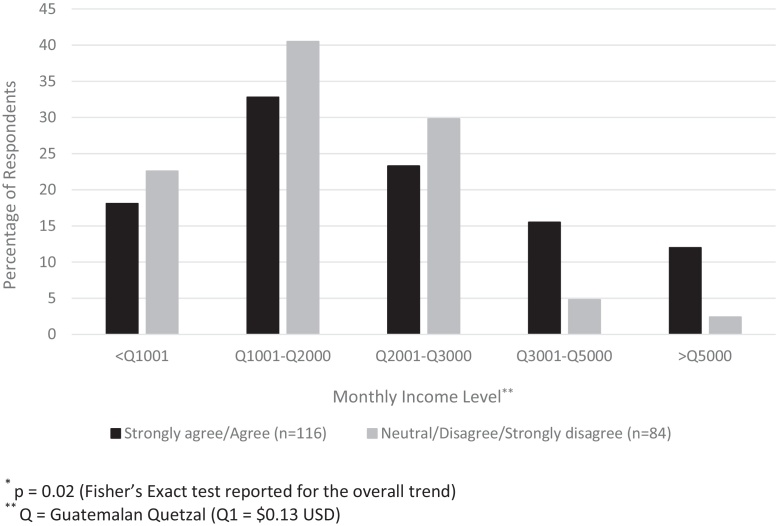
Comparison* of those who agree vs. those who do not agree with the statement ‘Would be willing to pay for text message reminders’ by monthly income level.